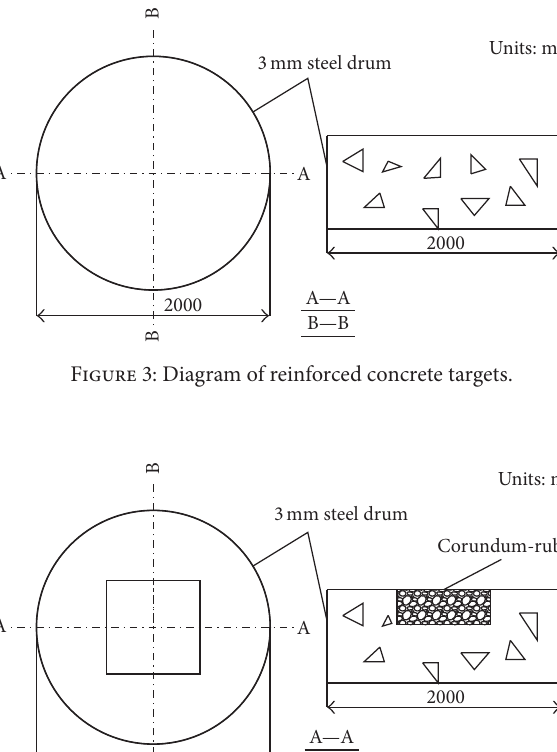
Figure 4: Diagram of CRC